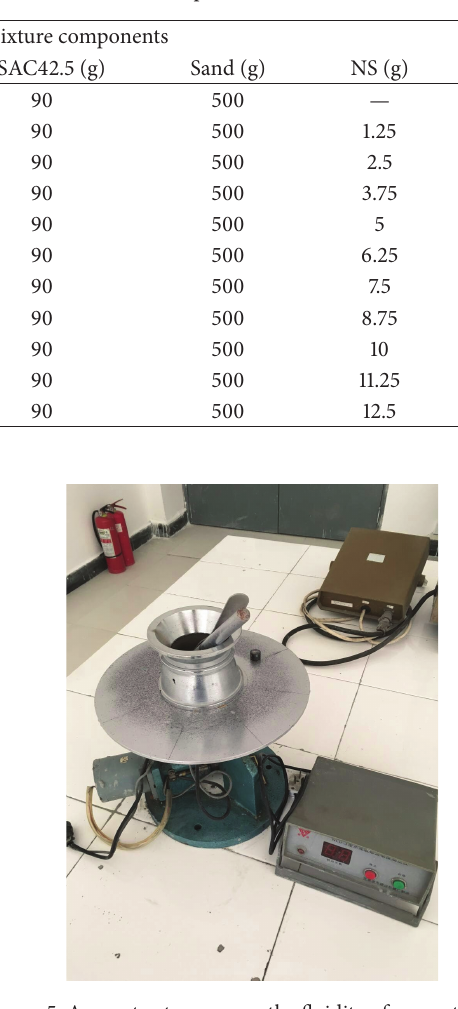
Table 4: Mix proportion of different cement mortars with different NS particle size.